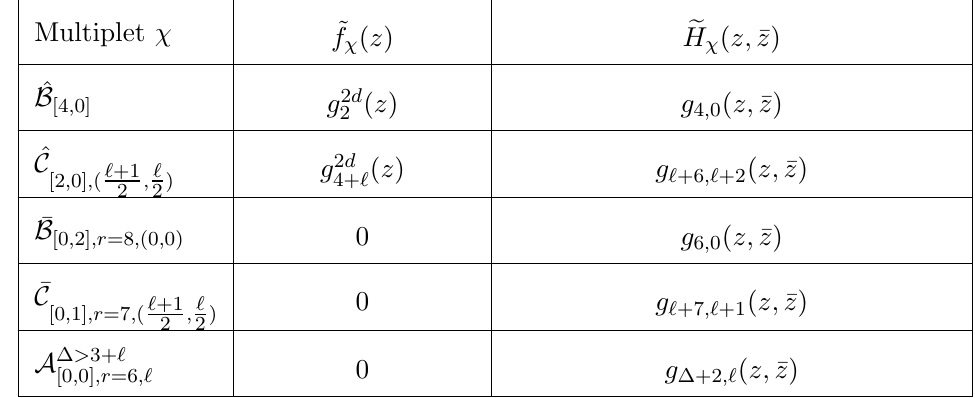
Table 5 . Contributions of the various N = 3 multiplets appearing in the chiral OPE (3.22), for R = 2, to the functions ~ f (cid:31) ( z ) and e H (cid:31) ( z; (cid:22) z ). Note that at the unitarity bound (see (3.37)) of the long multiplet we (cid:12)nd two types (for ‘ = 0 and ‘ 6 = 0) of short multiplets which do not contribute to the chiral algebra, namely (cid:22) B and (cid:22) C . When considering identical ^ B [0 ; 2] ;r =8 ; (0 ; 0) [2 ; 0] [0 ; 1] ;r =7 ; ( ‘ +1 2 ; ‘ 2) operators Bose symmetry requires ‘ to be even for A (cid:1) > 3+ ‘ and odd for (cid:22) C [0 ; 0] ;r =6 ;‘ [0 ; 1] ;r =7 ; ( ‘ +1 2 ; ‘ 2 )